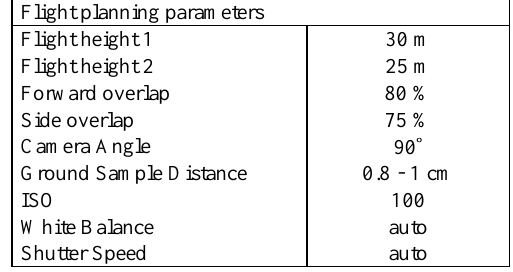
Table 2. Flight planning